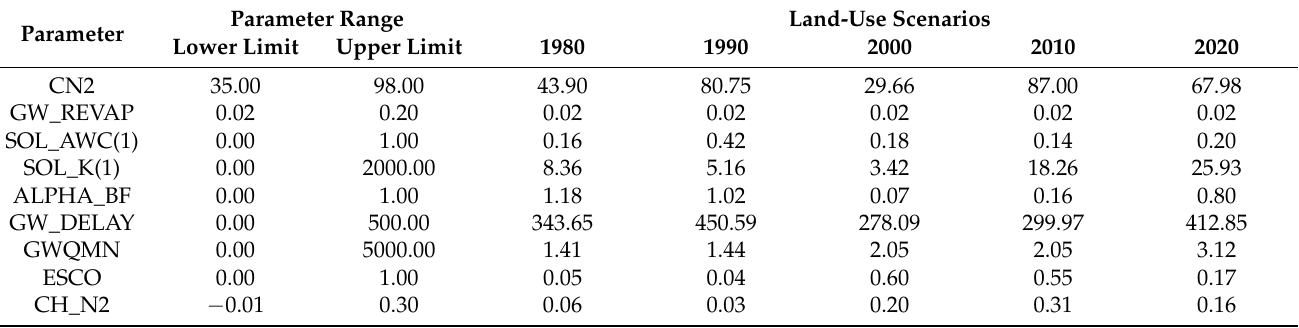
Table 4. Results of parameter calibration of the Huangbizhuang Station.